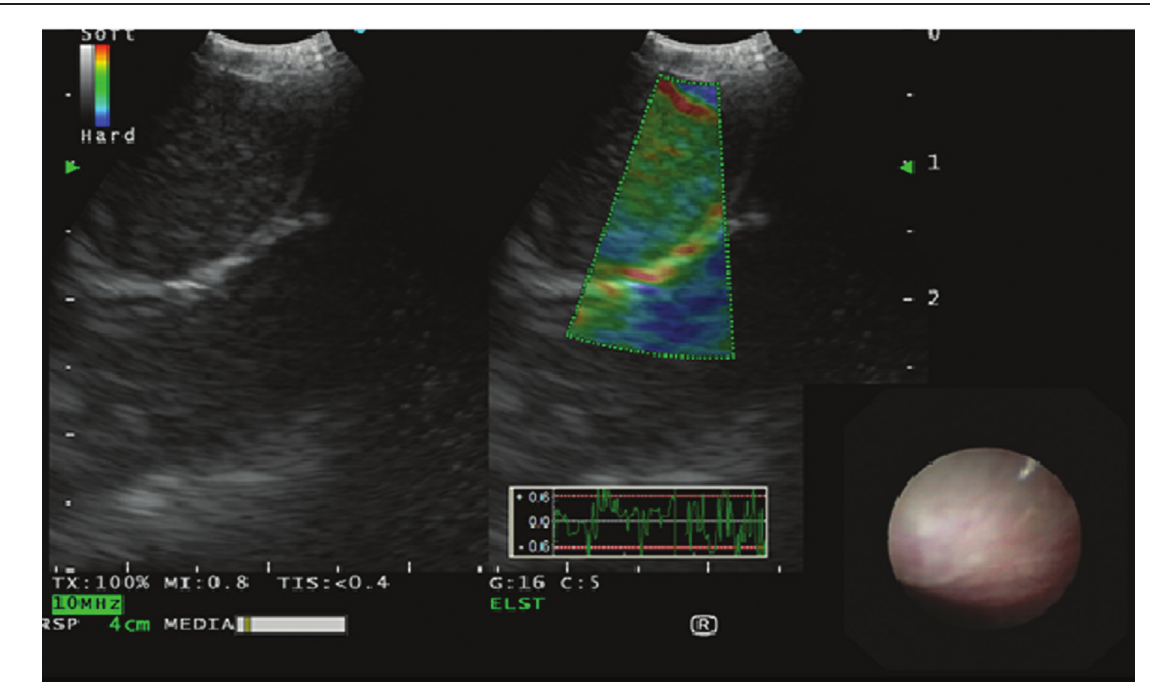
Type 1 can be seen on the elastography image.